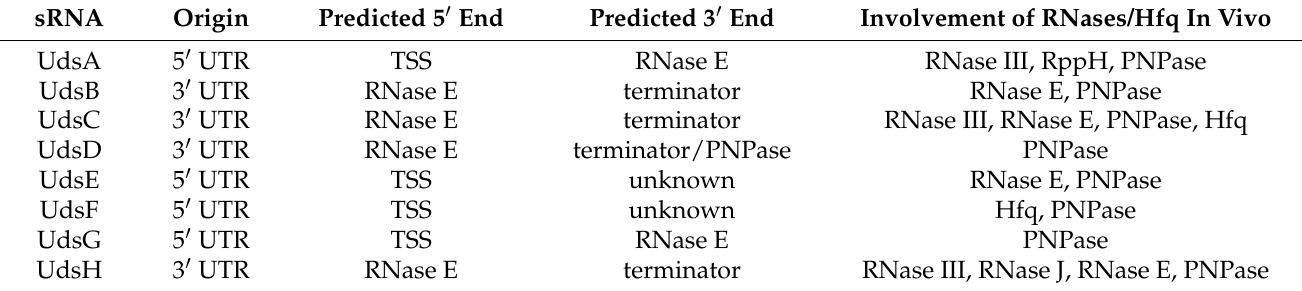
Table 1. Comparison of the predicted generation mechanisms for the described UTR-derived sRNAs and the determined enzymes, which are involved in processing and maturation in